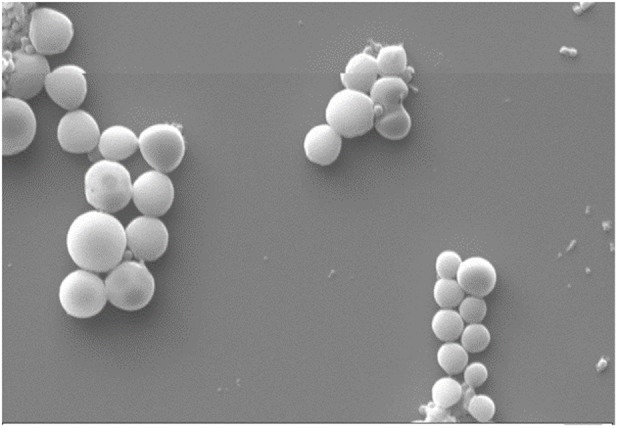
Scanning electron microscopy of Cur-PLGA.